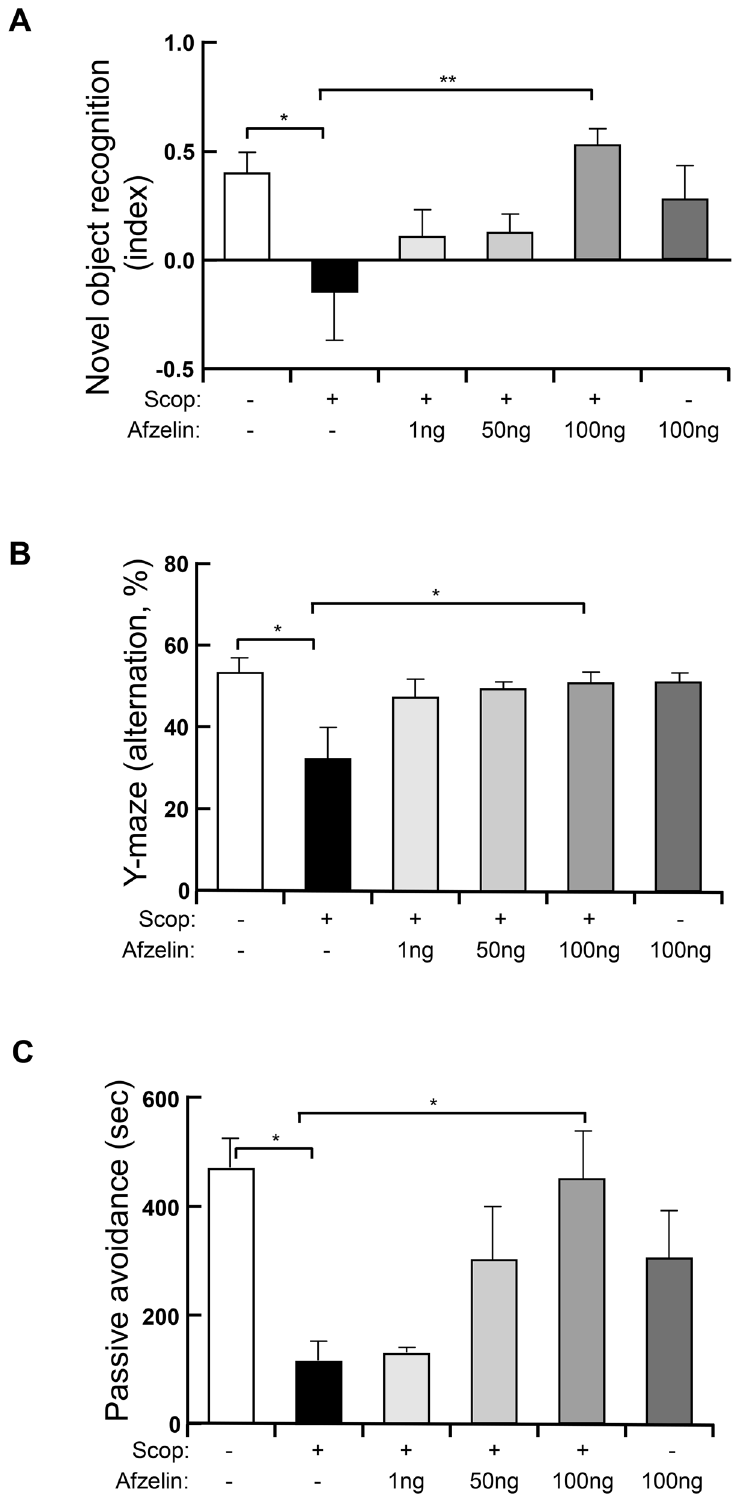
Figure 2. The optimal dose of afzelin in cognition and memory behaviors. Standard C57BL/6 mice (4 weeks old) were pre- treated into third-ventricle of brains cannula with specific doses (0.5 µl, 1, 50, 100 ng/µl) of Afzelin or PBS (0.5 µl) for one month. The mice were received with scopolamine (Scop) injection (i.p. 0.8 mg/kg) before each behavior test. ( A – C ) Novel object recognition tests ( A ), Y-maze tests ( B ) and passive avoidance tests ( C ) were conducted on the control (Scop −,